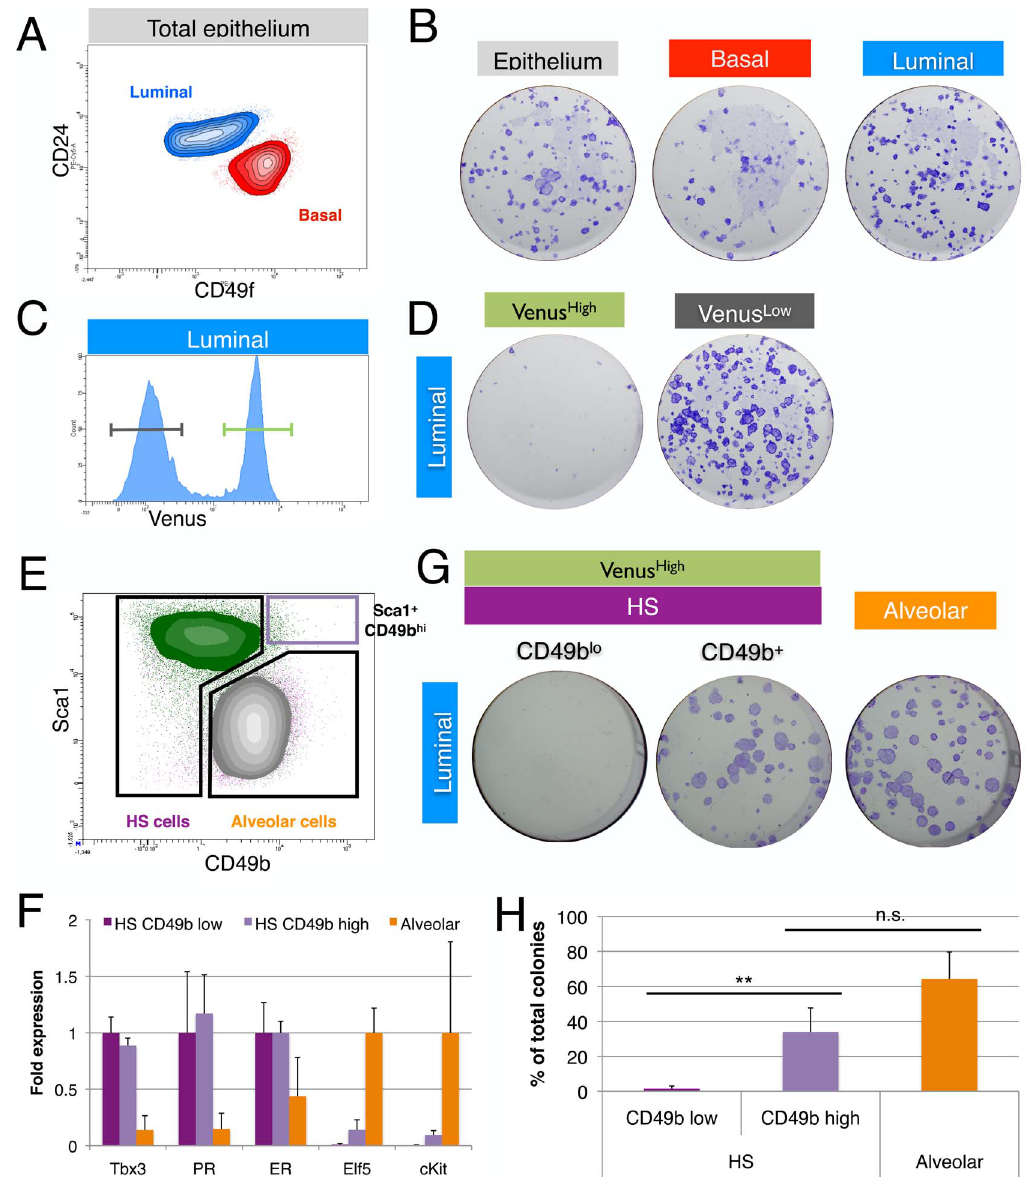
Figure 3. Tbx3 marks the hormone sensing lineage, including ER + progenitor cells. (A) Combined density/contour plot of mammary epithelial cells (from a pool of 5 Tbx3 + /Venus mice) separated into basal (red) and luminal (blue) cells based on CD24 and alpha6-integrin (CD49f) expression. (B) Colony forming potential of 1000 sorted cells from each population, representative of two independent experiments. (C) Histogram of luminal mammary epithelial cells Venus High (luminal) and Venus Low (luminal) cells sorted for colony forming assay (from a pool of 5 Tbx3 + /Venus mice per experiment). (D) Colony forming potential of 1000 sorted cells from each population, representative of two independent experiments. (E) FACS profile of hormone-sensing (CD49b high and CD49b low ) and alveolar progenitor cells that were used for colony assays. Cells are color-coded based on Venus expression (green=Venus High , grey=Venus Low ). (F) Fold change in Tbx3, progesterone receptor (PR) and estrogen receptor (ER) mRNA expression of sorted CD49b high and CD49b low hormone-sensing cells and alveolar progenitor cells, relative to CD49b low hormone-sensing cells (dark purple bar). Fold change in Elf5 and cKit mRNA expression is shown relative to luminal alveolar cells (orange bar). (G) Colony forming potential of 1000 sorted luminal cells: CD49b low and CD49b high hormone-sensing cells and alveolar progenitor cells. (H) Quantification of colony forming assays with HS cells (Sca1 high CD49b low ), HS progenitor cells (Sca1 high Cd49b high ) and alveolar progenitor cells (Sca1 low CD49b high ). Bars represent the mean of three independent pools of 5–6 adult virgin Tbx3 + /Venus animals 6 SD. HS progenitor cells form more colonies than HS cells (p=0.02, paired t-test) and there is no significant difference in colony forming potential between HS progenitor and alveolar progenitor cells (p=0.21, paired t-test).